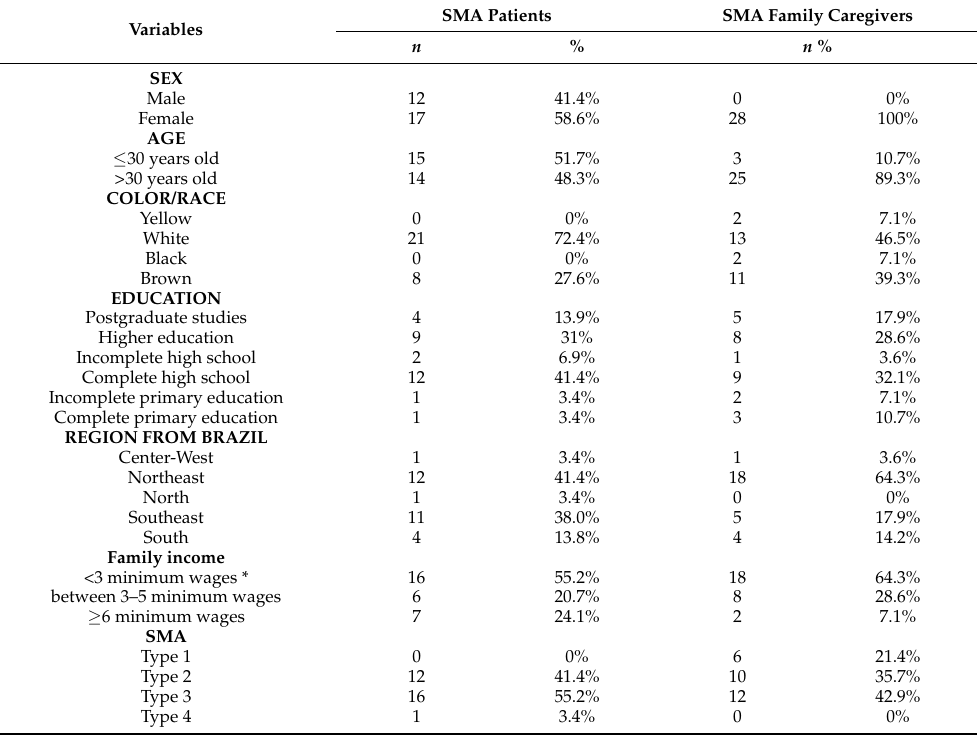
Table 1. Demographic profile of SMA patients and family caregivers who participated in this study. SMA Variables